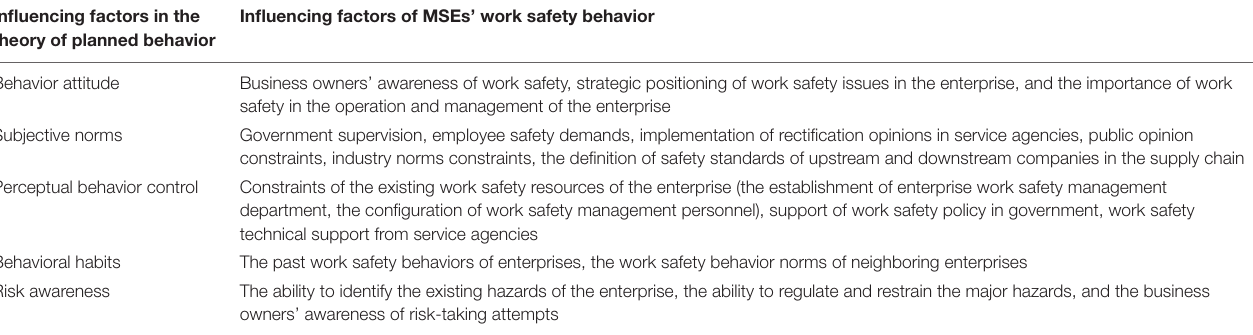
TABLE 2 | The correspondence relationship between the exogenous variables and the influencing factors of MSEs’ work safety behaviors in high-risk industries. Influencing factors in the Influencing factors of MSEs’ work safety behavior theory of planned behavior Behavior